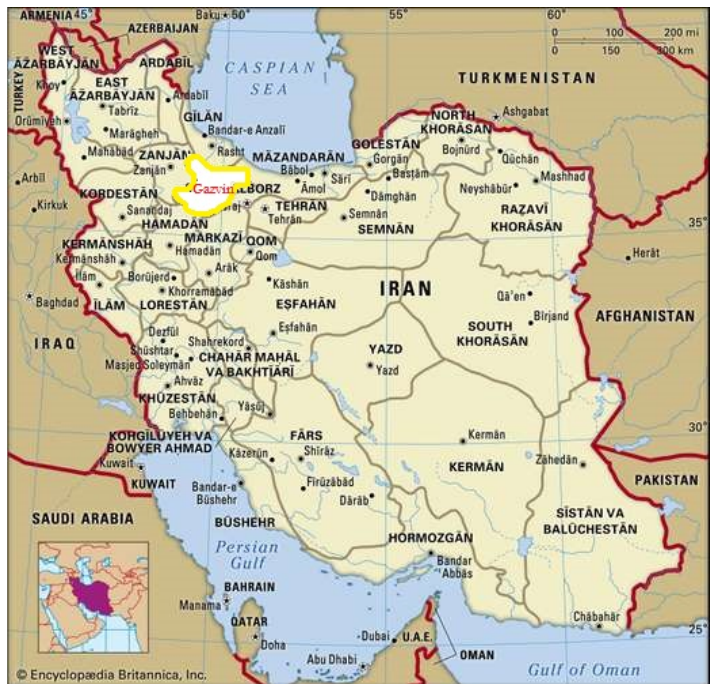
Figure 1. Map of Iran's national divisions (Taken from the Amazon